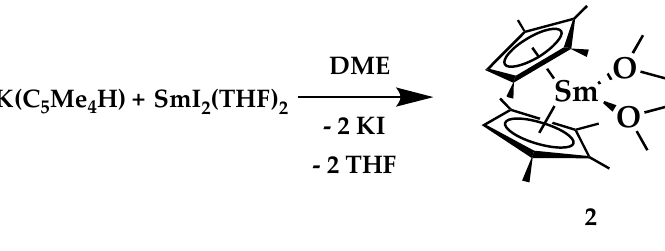
Figure 1. ORTEP representation of complex 2 with selective atom labeling. Ellipsoids are drawn at the 50% probability level. For clarity, hydrogen atoms and the second molecule in the asymmetric unit are not shown.